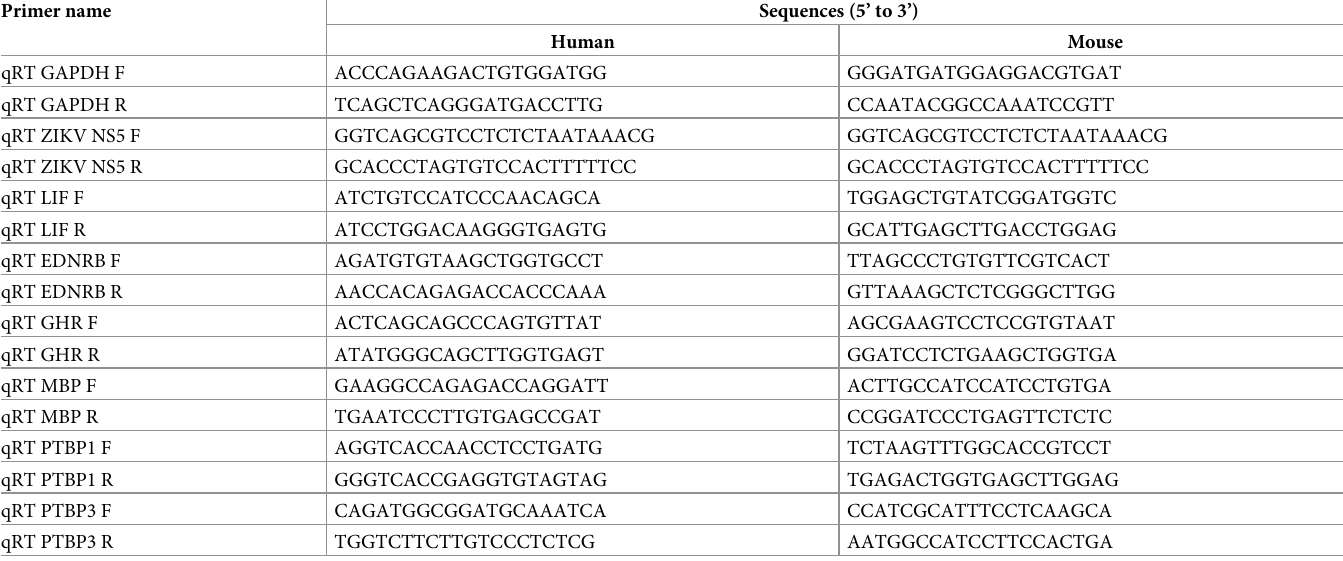
Table 1. Information of primers sequences for qPCR assay in this study. Primer